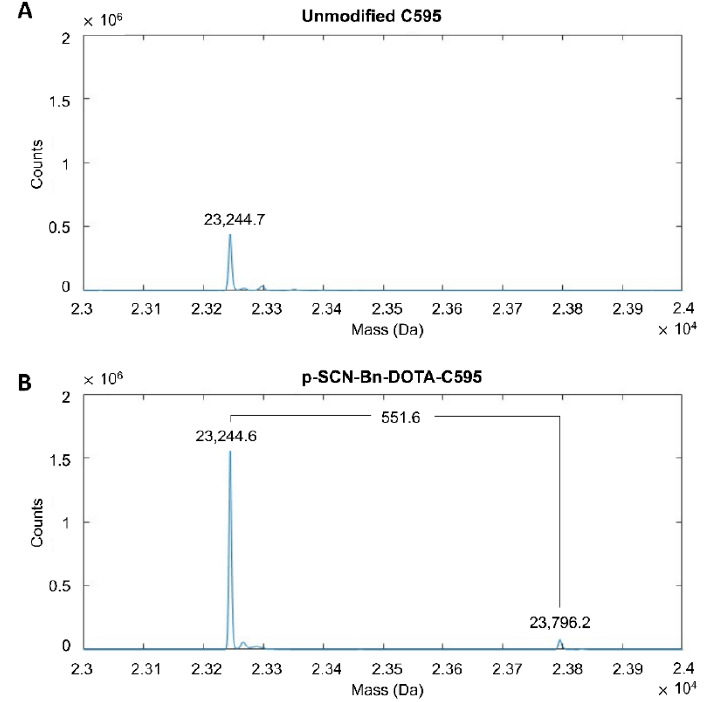
Figure 1. Mass spectra of the light chains of ( A ) unmodified C595 and ( B ) p-SCN-Bn-DOTA-C595 conjugate.